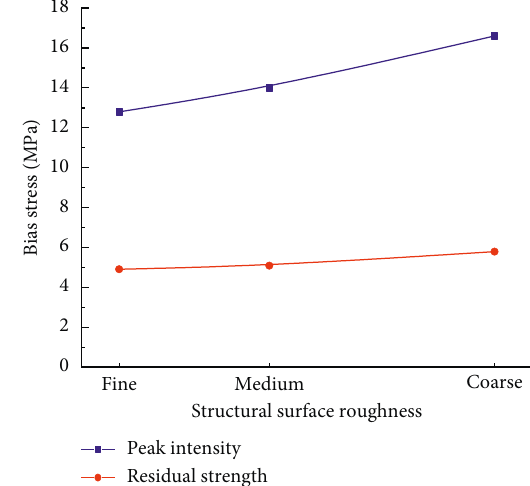
Figure 8: Variation curve of peak strength and residual strength of specimen with surface